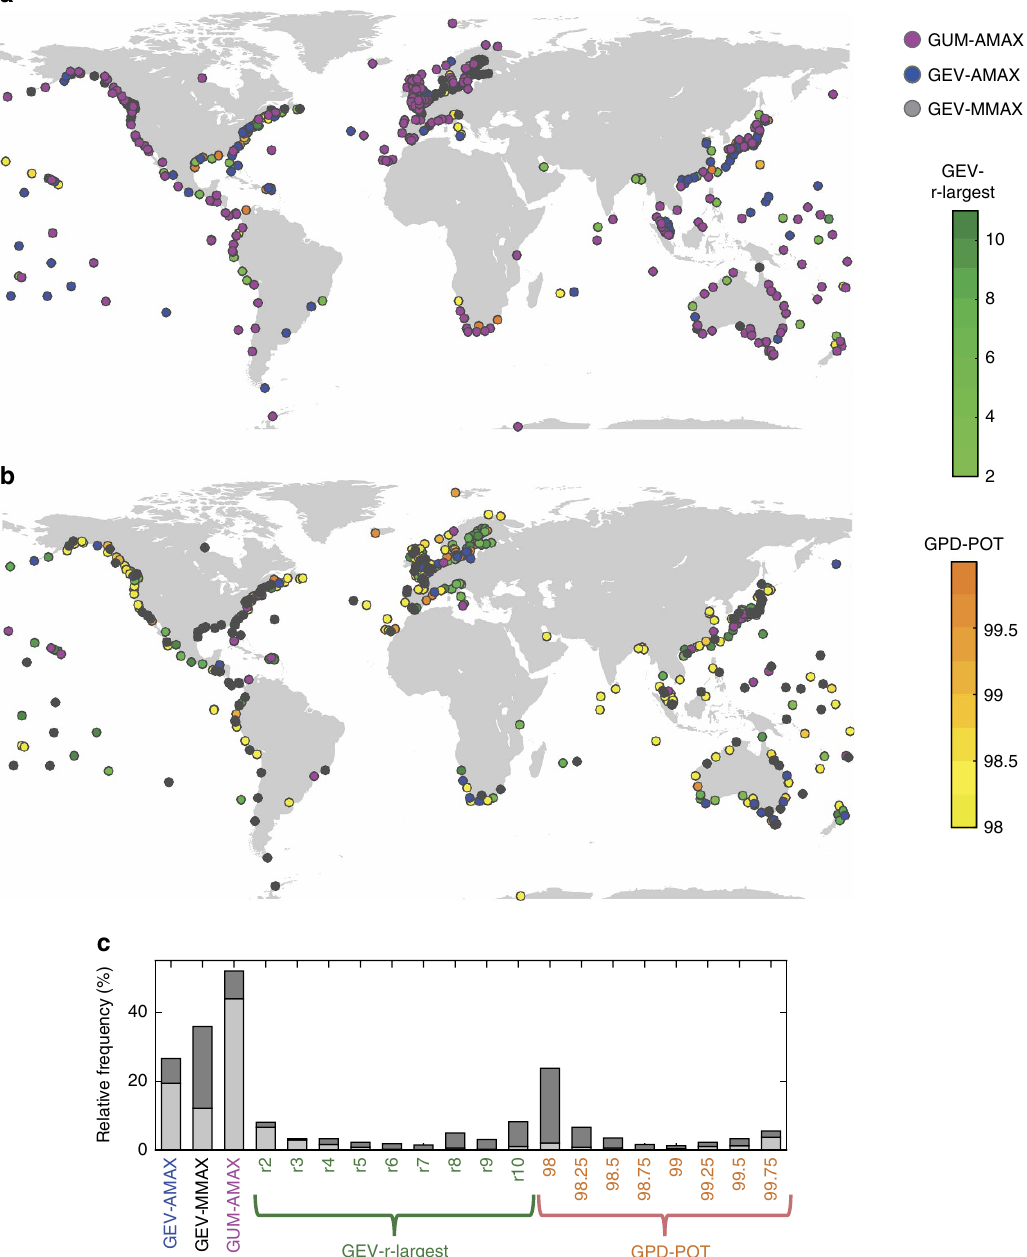
Figure 3 | Extreme value analysis methods leading to conservative and optimistic results. ( a ) Methods leading to the highest and ( b ) methods leading to the lowest 100-year return water levels at individual sites. ( c ) Relative frequency of different methods leading to the highest (light grey) and lowest (dark grey) 100-year return water